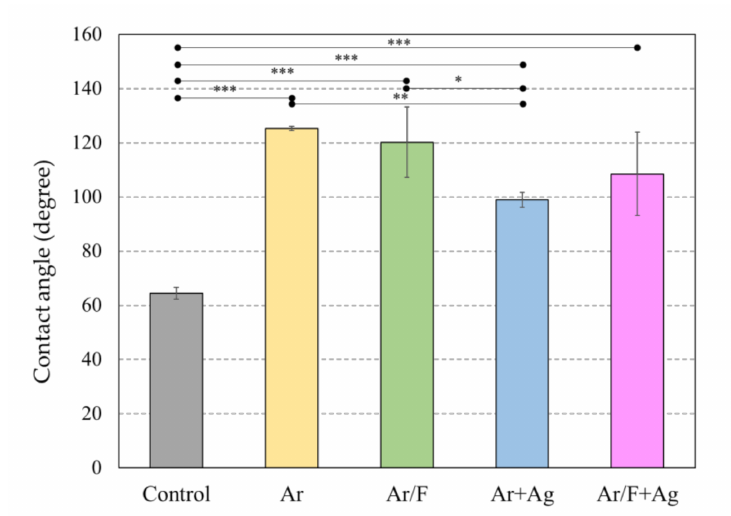
Figure 4. The water contact angles of each PMMA specimen. * p < 0.05, ** p < 0.01, *** p < 0.001 (ANOVA / Tukey, α = 0.05).